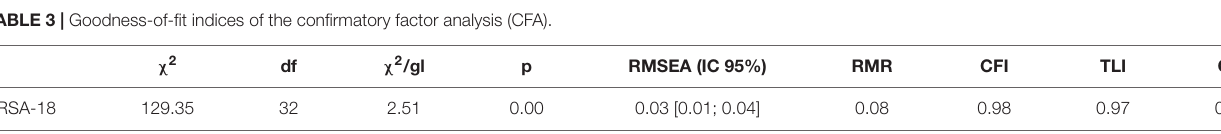
TABLE 3 | Goodness-of-fit indices of the confirmatory factor analysis